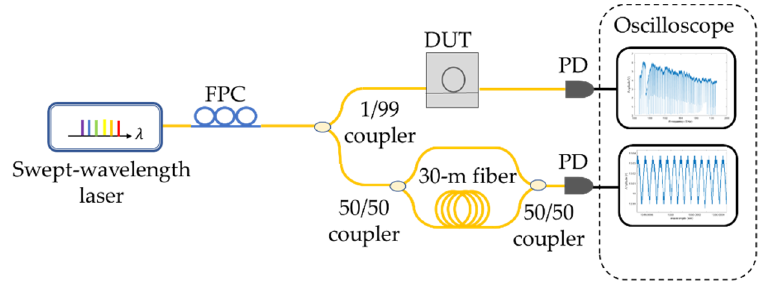
Figure 6. Scheme of the experimental setup.